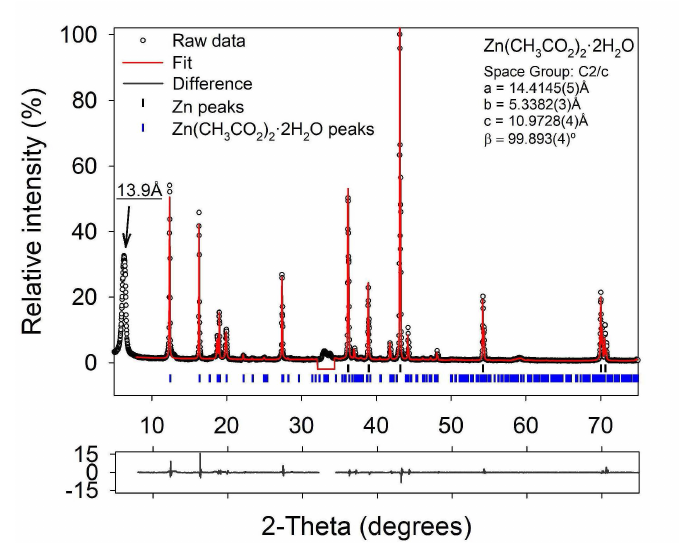
Figure 4. Fitted X-ray diffraction pattern of an as-made porous Zn monolith before cycling. The Zn phase was fitted using a full structure model whilst the Zn(CH 3 CO 2 ) 2 · 2H 2 O phase was fitted using a structureless Pawley-type fitting. Fitted unit cell parameters for Zn(CH 3 CO 2 ) 2 · 2H 2 O are inset. Due to peak overlaps a region from 32.2 ◦ to 34.4 ◦ 2-theta was excluded from fitting.